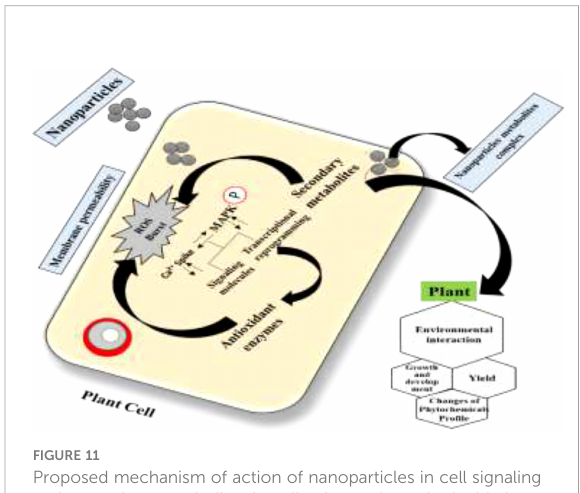
FIGURE 11 Proposed mechanism of action of nanoparticles in cell signaling and secondary metabolism in cell cultures through elucidation of the mitogen-activated protein kinase (MAPK) pathway